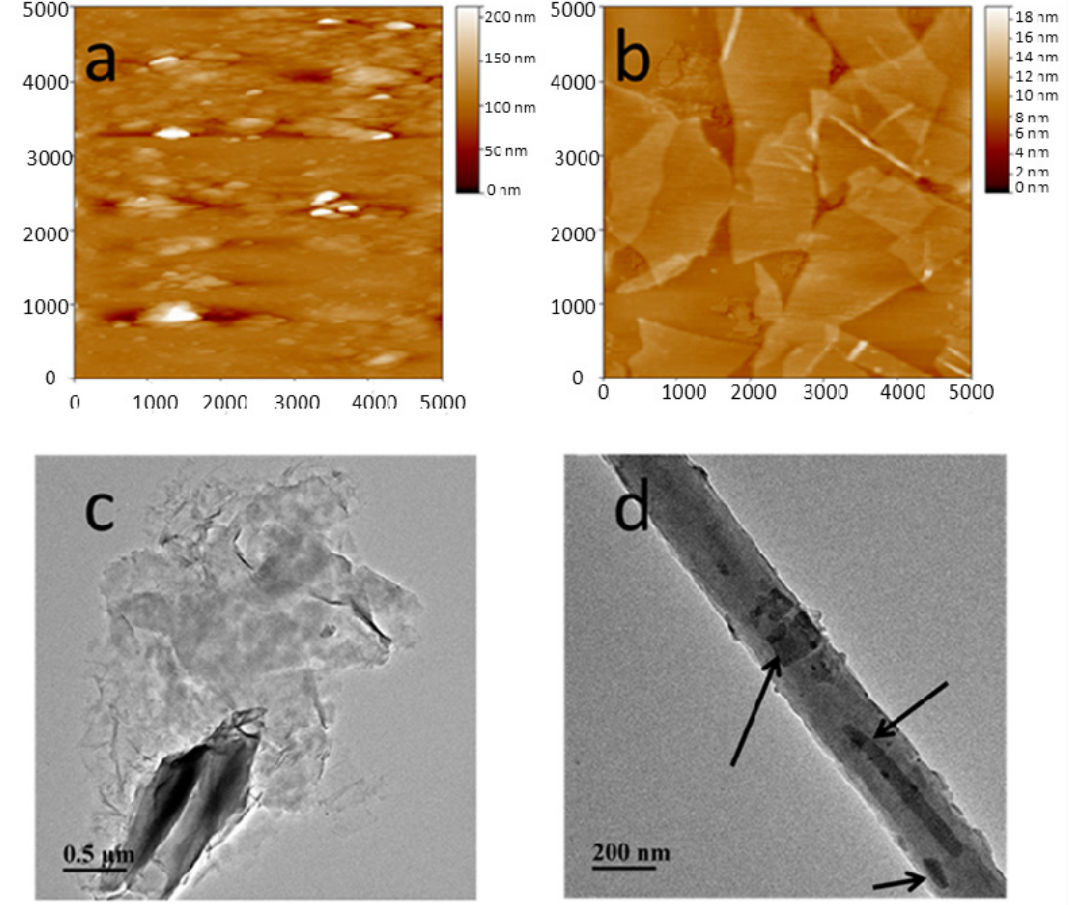
Figure 1. ( a ) tapping mode topography of MMT. ( b ) tapping mode topography of GO. ( c ) TEM of MMT/GO complexes. ( d ) TEM of PAN/MMT/GO-2 composite